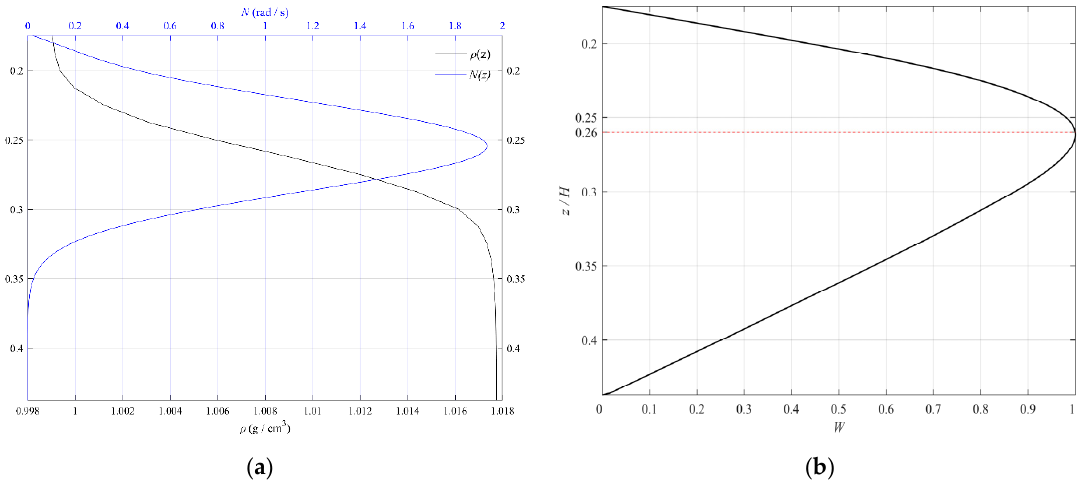
Figure 3. Profile of the density and buoyancy frequency in S3 ( a ) and the vertical modal function calculated by the Thomson–Haskell method in S3 ( b ).